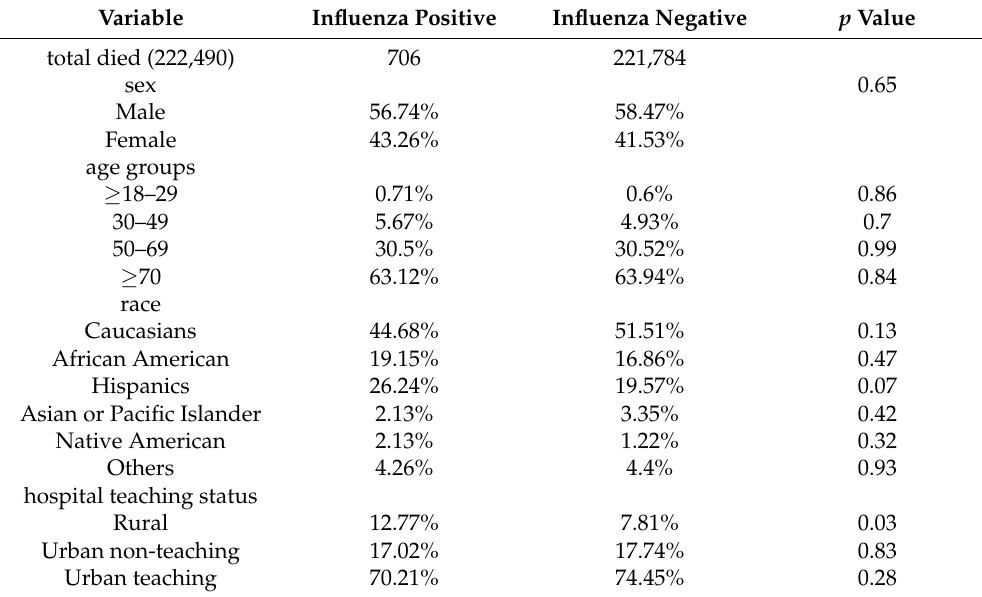
Table 3. Mortality breakdown (for before matching sample).